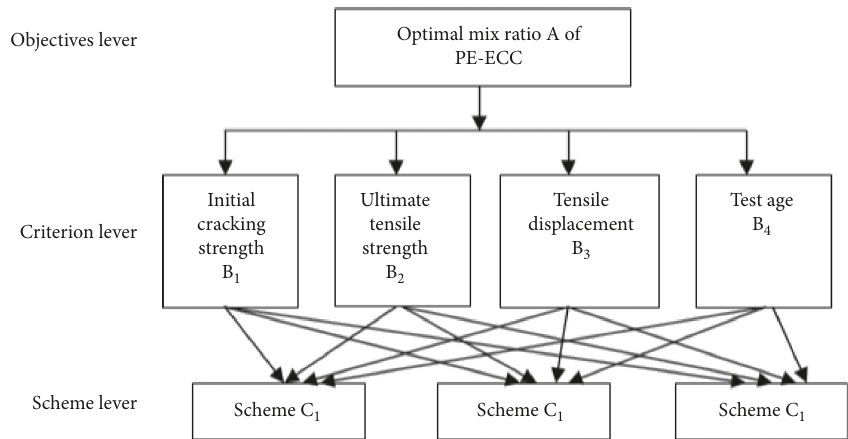
Figure 3: PE-ECC hierarchical model. Table 6: Comparison of factor